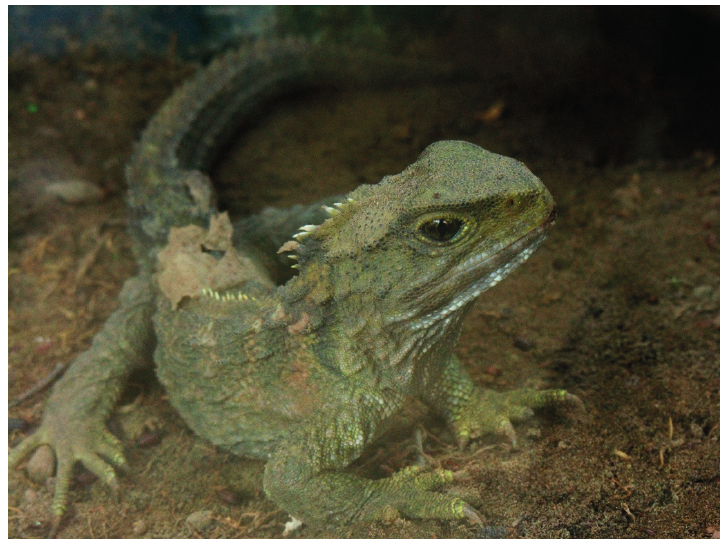
Figure 3. Sphenodon punctatus , Tuatara, Nga Manu, Waikanae, New Zealand. Photo by PhillipC